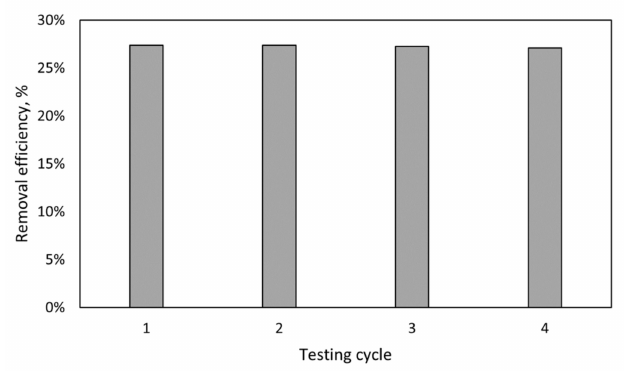
Figure 10. Reusability of CAT-1 for the photocatalytic removal of imidacloprid.